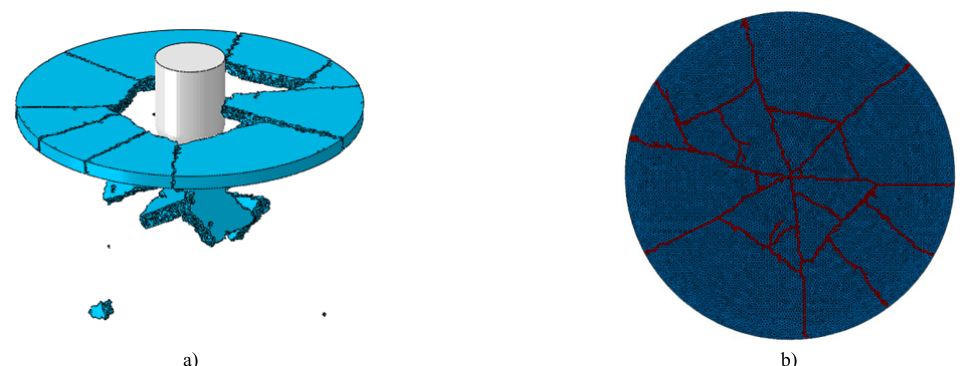
Fig. 12 Glass cracking and fragmentation at t = 10ms for drop weight impact simulation with immediate failure model; a) perspective view, b) bottom view of failed elements.